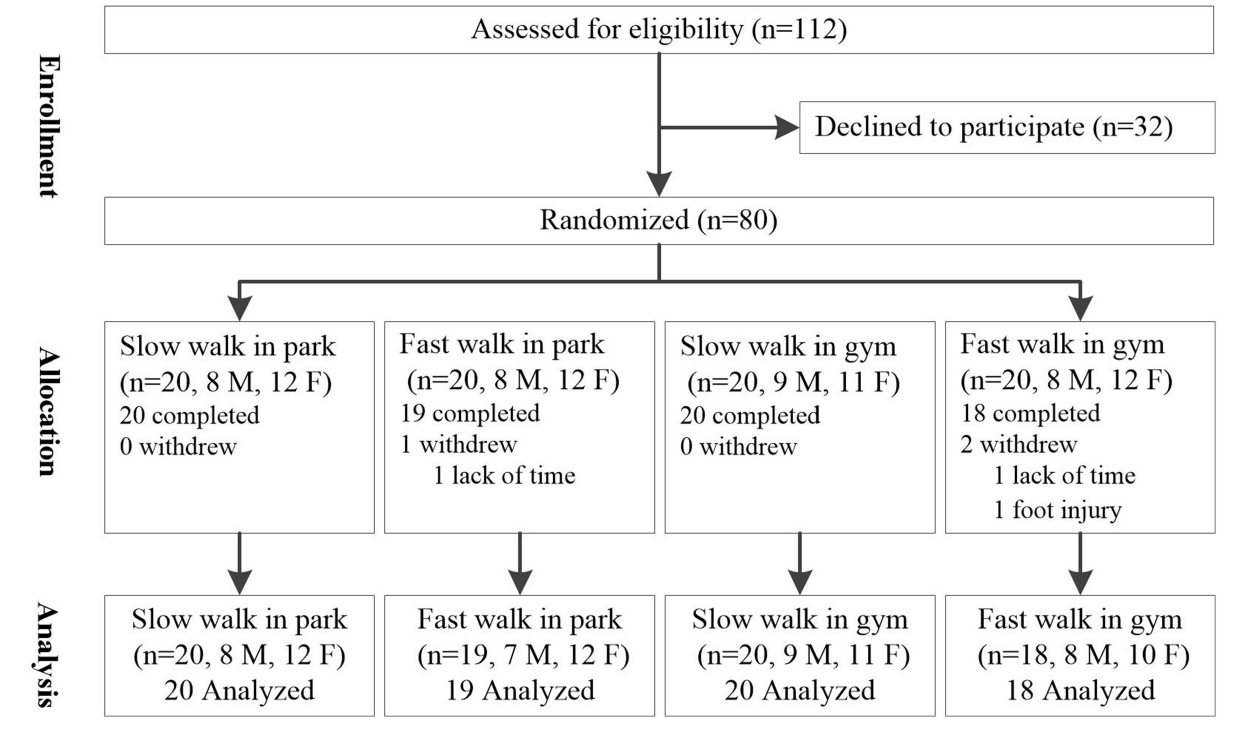
TABLE 1 | Means and standard deviations for the physical status of the subjects. Exercise in park Exercise in gym Slow walk ( N = 20) Fast walk ( N = 19) Slow walk ( N = 20) Fast walk ( N = 18) Mean (S.D.) Mean (S.D.) Mean (S.D.) Mean